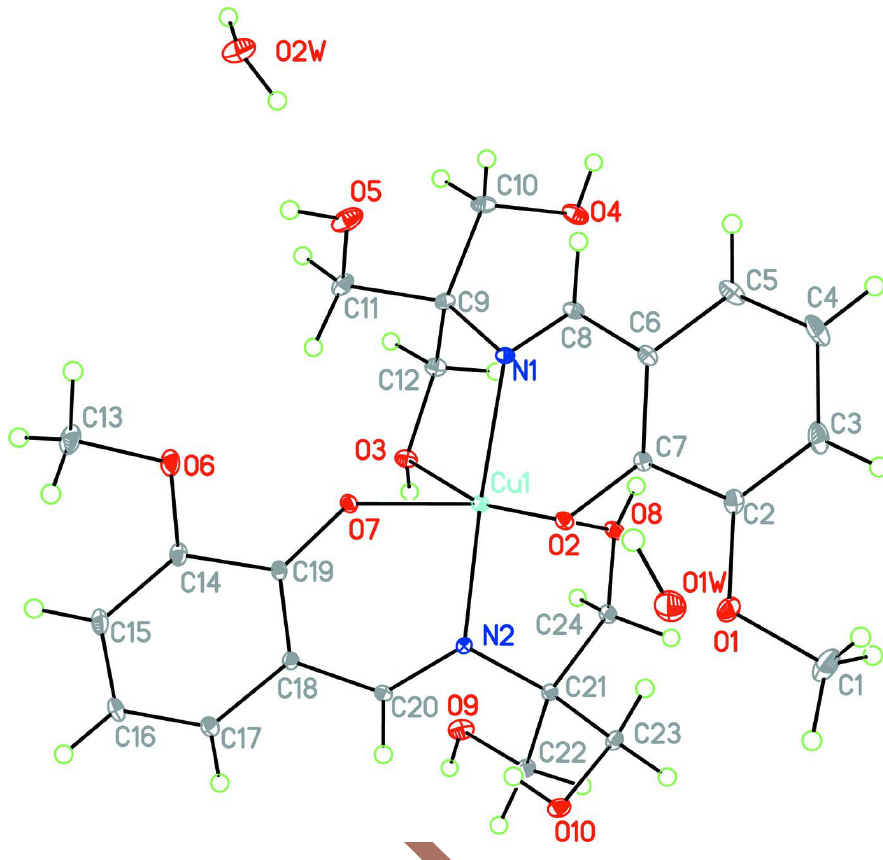
Figure 1 A view of (I) with Displacement ellipsoids drawn at the 30% probability level. Bis(6-methoxy-2-{[tris(hydroxymethyl)methyl]iminomethyl}phenolato)copper(II)